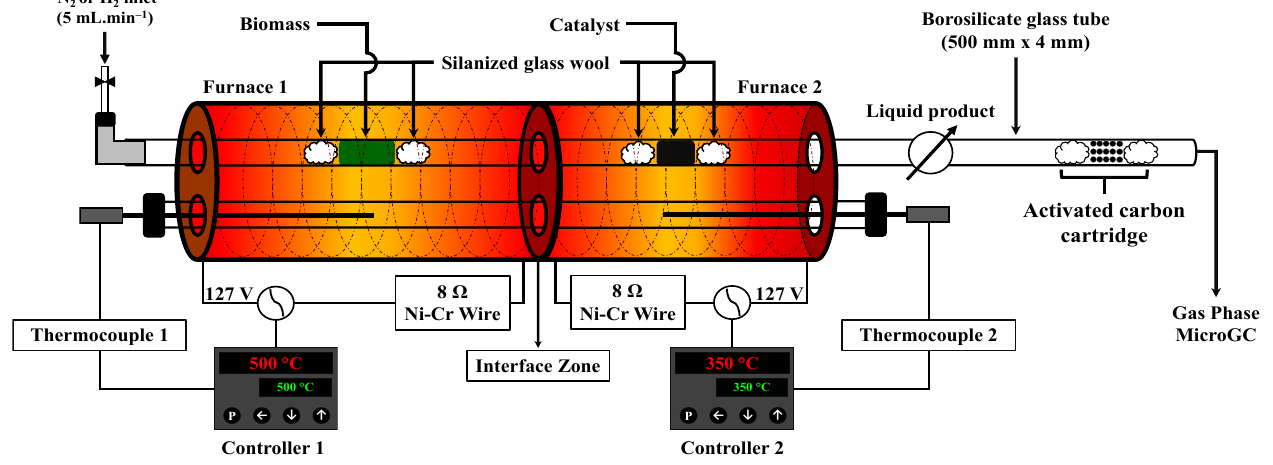
Figure 8. Micro-scale pyrolysis reactor.